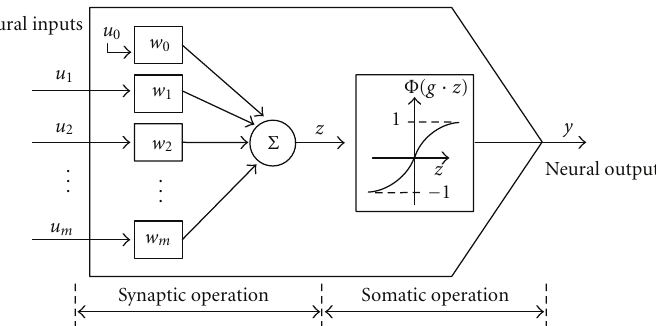
Figure 6: The structure of a neural unit consisting of synaptic operation and somatic operation. Table 2: Evaluation of factors (evidences) and pre-processing (excluded mean, excluded variance, and variance influence function) of each factor (evidence). (number of factors (evidences), m = 14; number of evaluators, n = 50.) Evaluation Evaluators